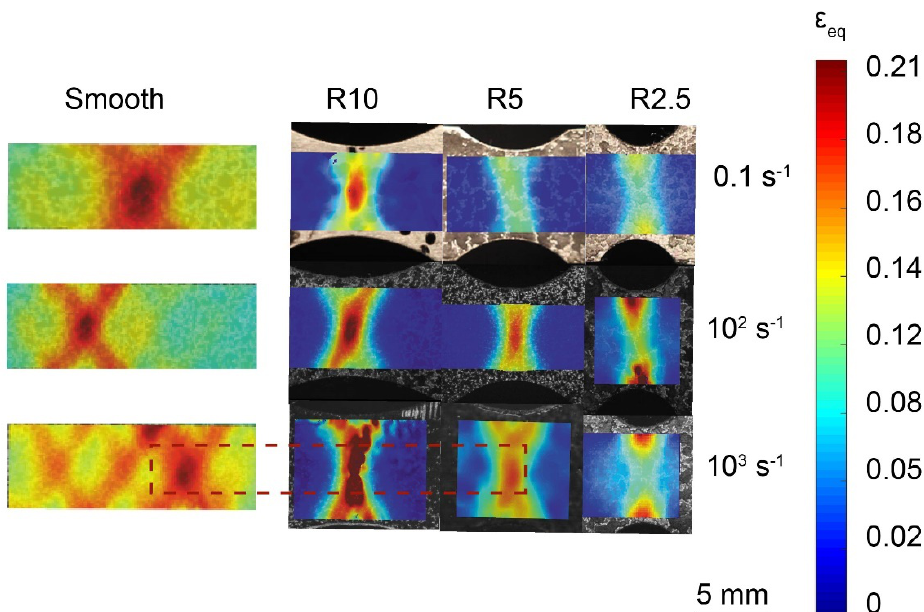
Figure 3. Equivalent strains in smooth specimens under tension with strain rates of 10 3 , 10 2 , and 0.1 s − 1 (top insert), and equivalent strains in specimens with notch radii of 10, 5, and 2.5 mm under tension at strain rates of 10 3 , 10 2 , and 0.1 s − 1 (bottom insert).